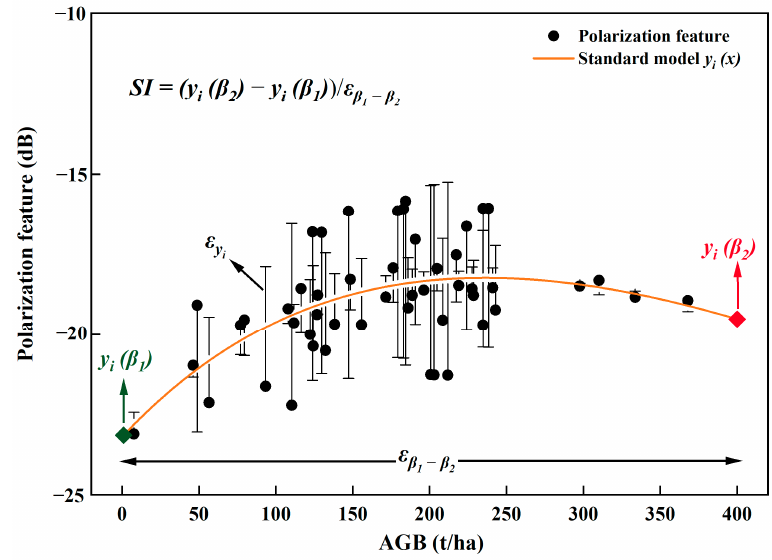
Figure 3. Schematic diagram of SI.